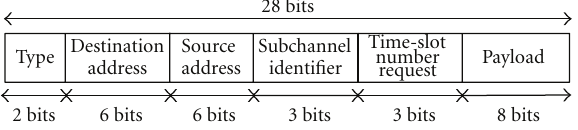
Figure 6: Best-e ff ort packet format SDM-TDM router.